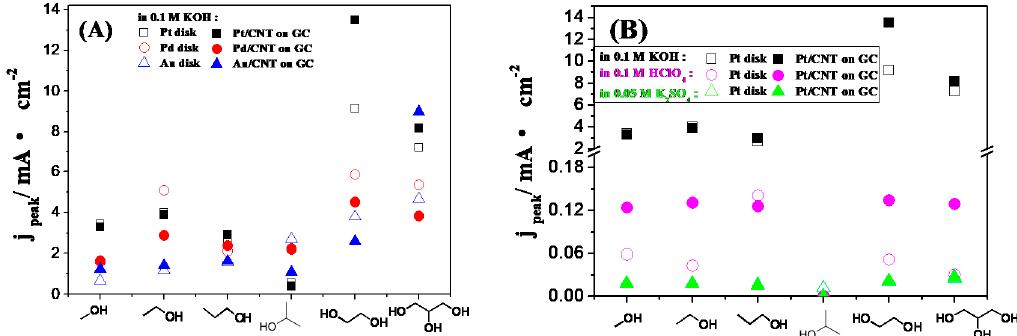
Figure 9. Comparison of the current density of electro-oxidation over different electrodes in 0.1 M KOH solution ( A ) and over a Pt electrode in different solutions ( B ). Hollow icons are for metal disk electrodes; solid icons are for nanocatalyst covered GC disk electrodes.